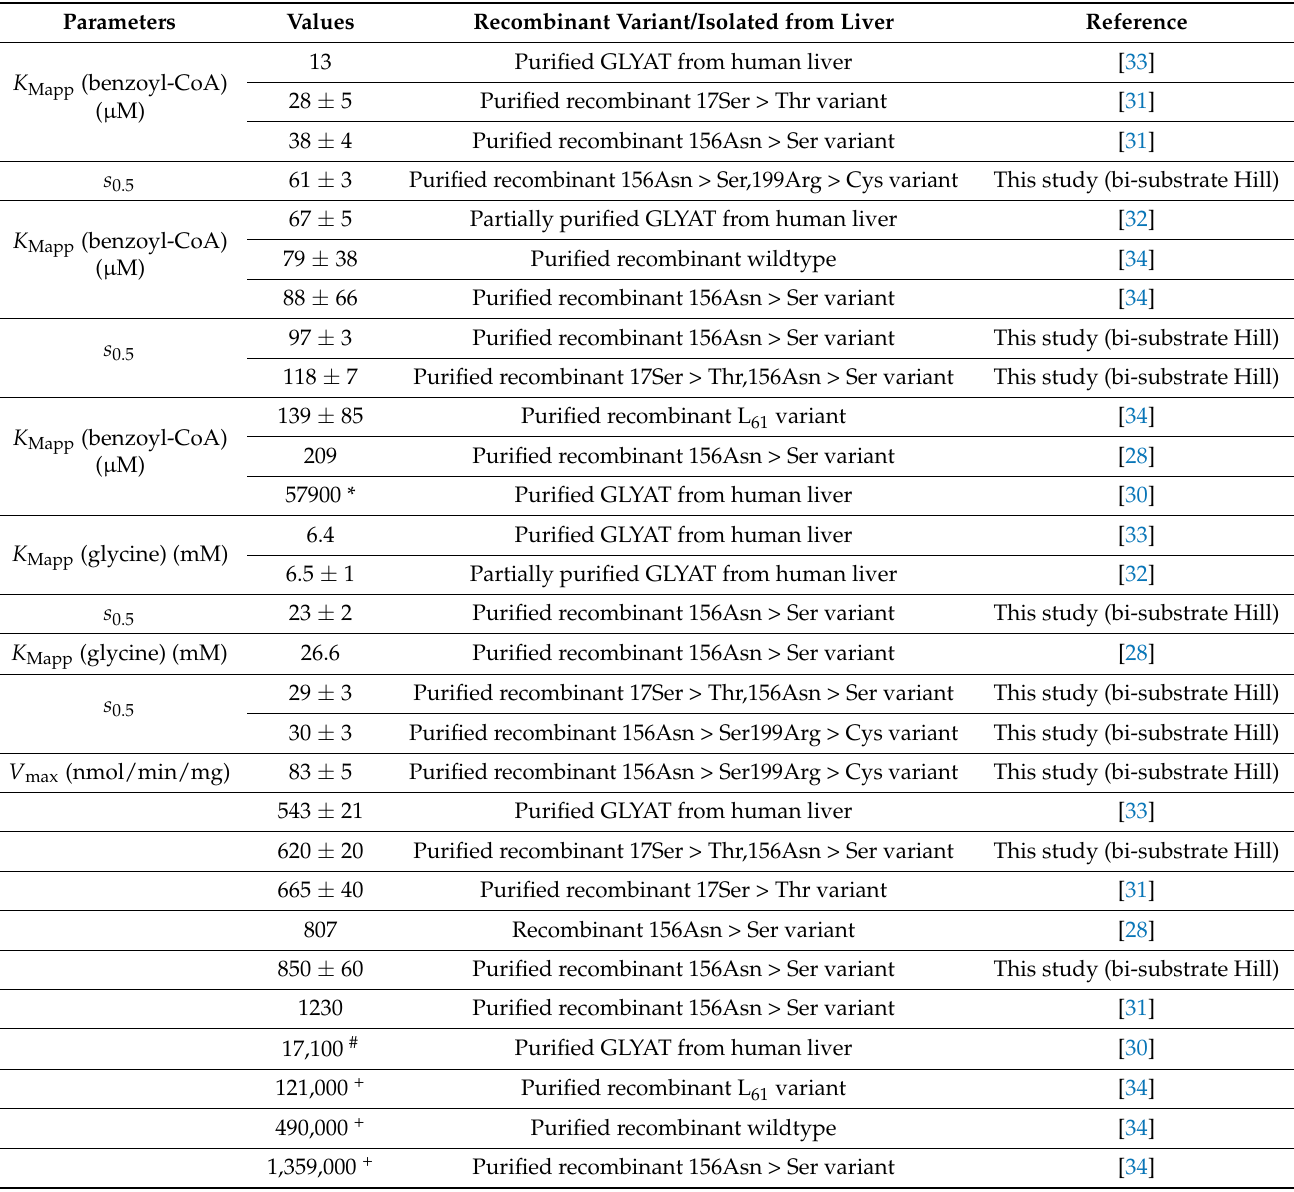
Table 4. Kinetic parameters of benzoyl–CoA and glycine for GLYAT as reported in the literature.